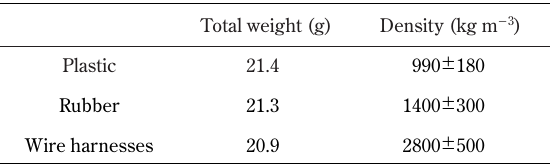
Table 1 Characteristics of each constituent of the automobile shredder